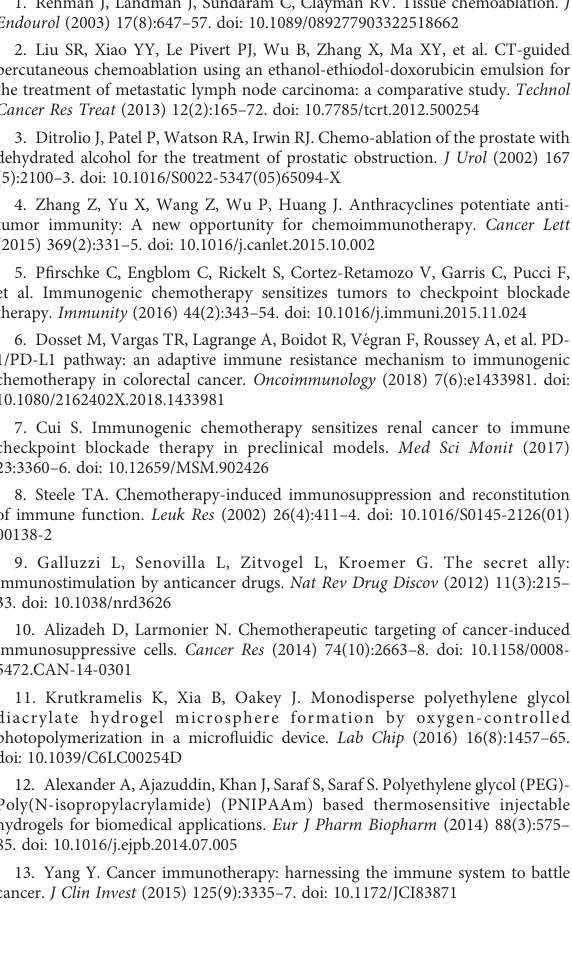
SUPPLEMENTARY FIGURE 1 Representative fl ow cytometry analysis of CD4 + CD25 + Foxp3 + cell in fi ltration in bilateral tumors of mice treated with epirubicin (EPI) gel. ns, not signi fi cant. (one-way ANOVA with Tukey ’ s test). SUPPLEMENTARY FIGURE 2 Representative fl ow cytometry analysis of CD3 + CD8 + cell in fi ltration in the righttumor ofmicetreated withepirubicin(EPI) gel.ns,notsigni fi cant. (Unpaired t